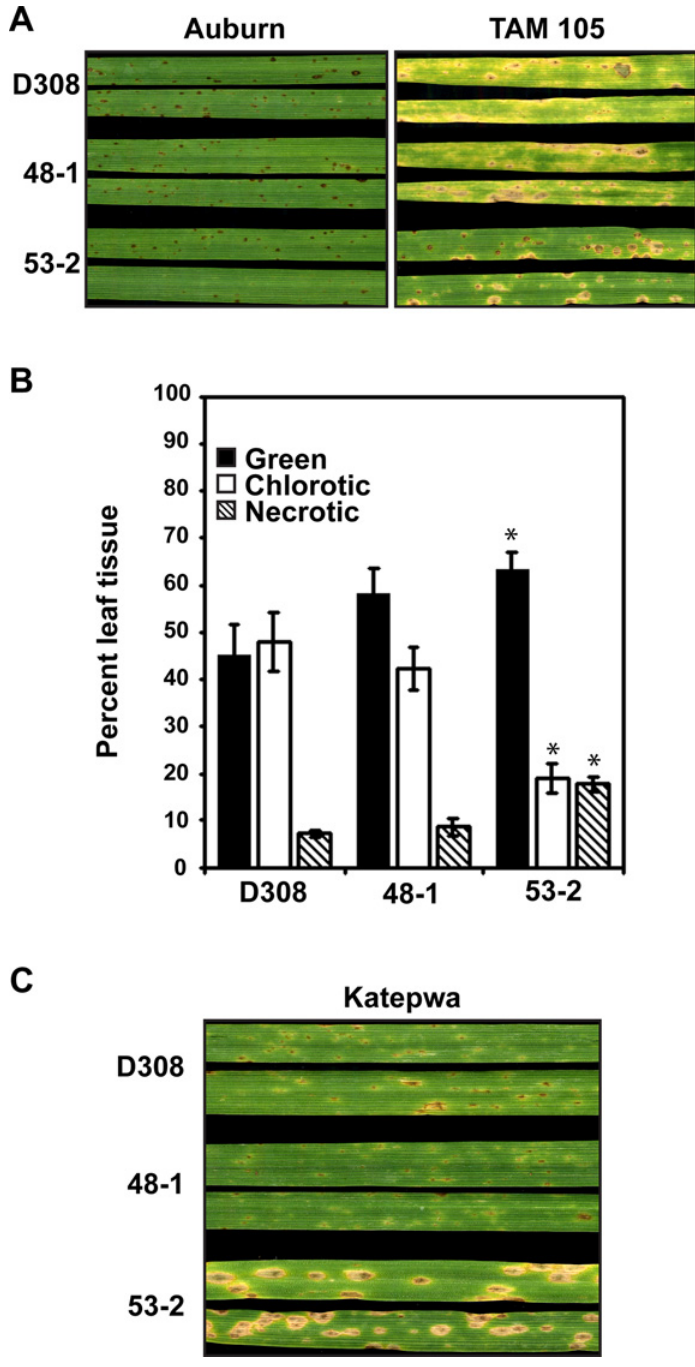
Fig 6. Symptom development induced by D308 and D308 transformants on ToxA-sensitive and -insensitive cultivars. The ToxA-insensitive and -sensitive cultivars, ‘ Auburn ’ and ‘ TAM 105 ’ , respectively, were inoculated and the symptoms (A) monitored and (B) symptoms on ‘ TAM 105 ’ quantified (chlorosis and necrosis). Bars represent means of three leaves per experiment from three independent experiments (nine total), error bars represent standard error, and * indicates a statistical difference from D308 as measured by a Student ’ s t-test ( P < 0.05). (C) Symptom development on the ToxA-sensitive cultivar, ‘ Katepwa ’ . Leaves were harvested 6 days post